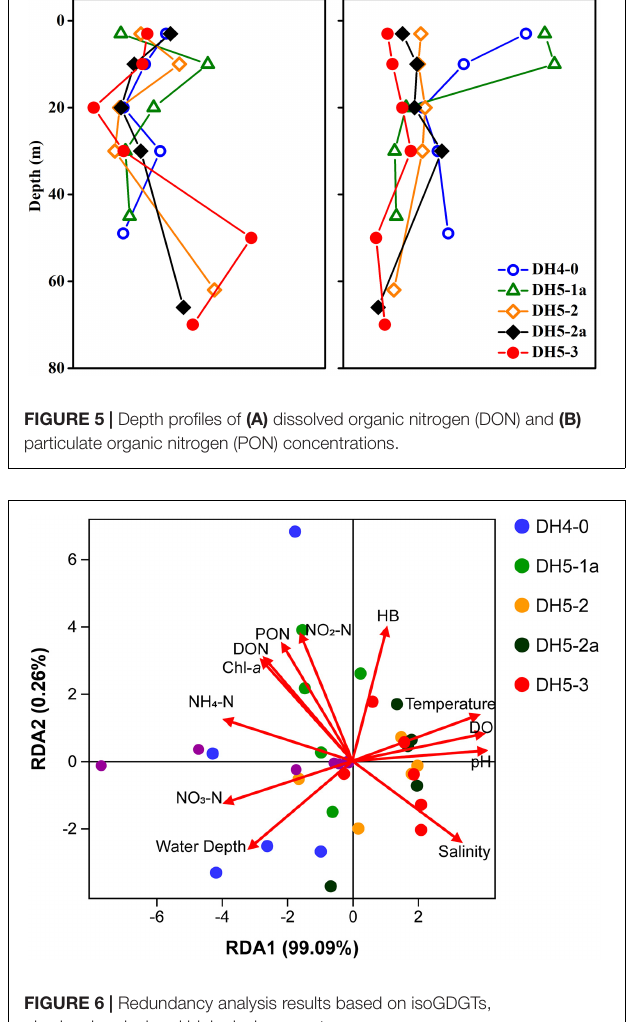
FIGURE 6 | Redundancy analysis results based on isoGDGTs, physicochemical and biological parameters.